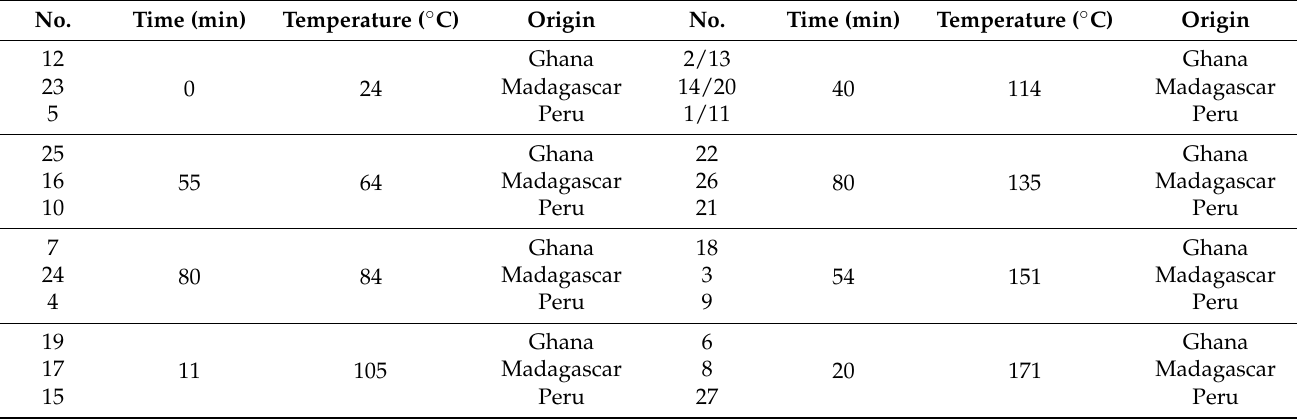
Table 3. List of the 27 samples analyzed by GCxGC-SCD, based on a randomized modified I-optimal experimental design with a duplicated center point. Samples are numbered according to their roasting order (see also